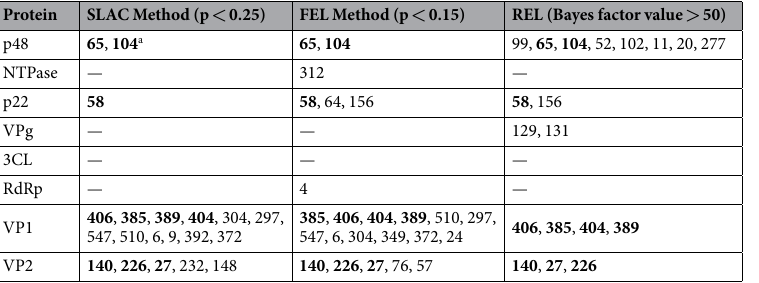
mutation rate of viral capsid protein and/or change the viral immunogenicity 23, 24 . Due to the lack of a suitable in